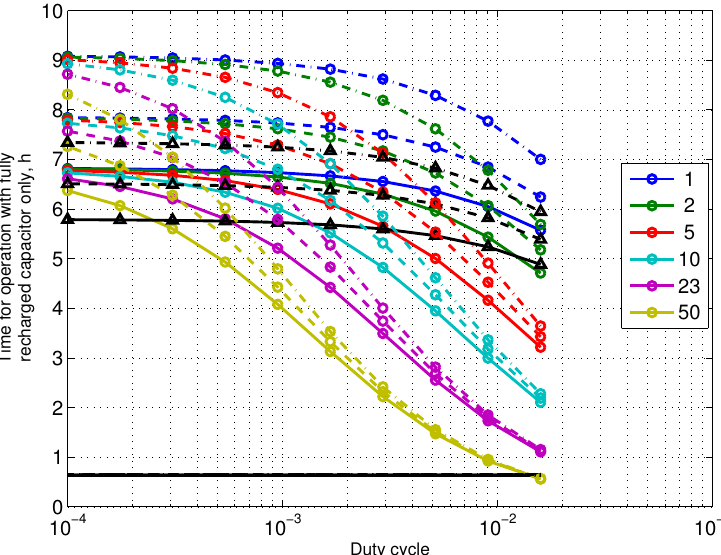
Figure 16. When M t = 1 and M r = 2, time for operation with capacitor ( C s = 0.35 F) only. Non-WuR in black (without triangles), passive WuR in colors indicating number of nodes for different host duty cycles per node ( β (cid:48) w ). Semi-passive WuR in black with triangles. Line type indicates used SC leakage